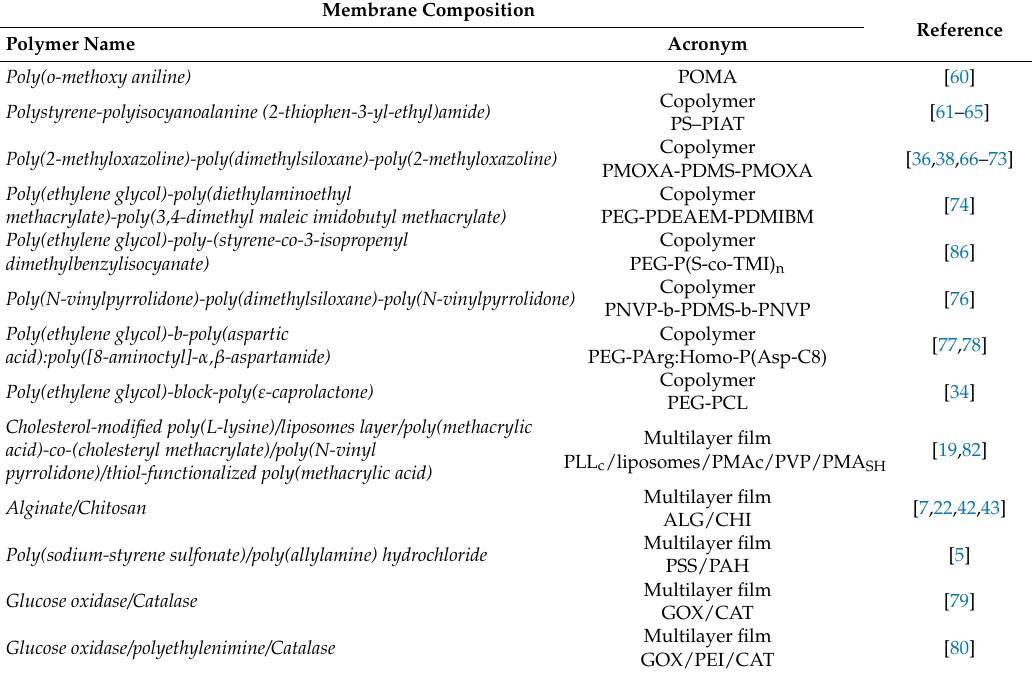
Table 2. List of polymers and membrane domains of polymer